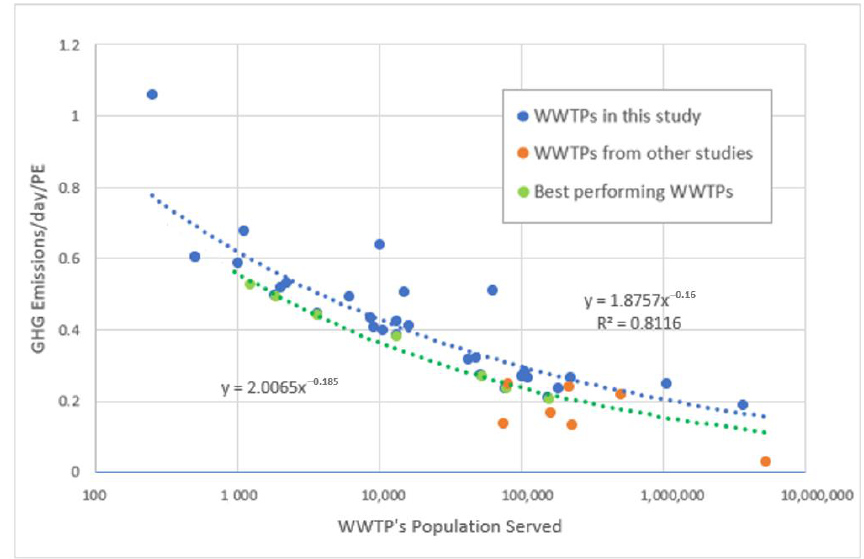
Figure 8. WWTP GHG Emissions by Population Served.